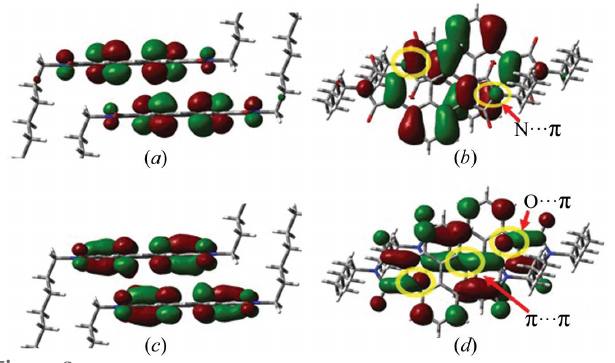
Figure 3 HOMOs (0.02 a.u.) for the P dimer of C 6 -PyDI in ( a ) side view and in ( b ) top view, and LUMOs (0.02 a.u.) for the P dimer of C 6 -PyDI in ( c ) side view and in ( d ) top